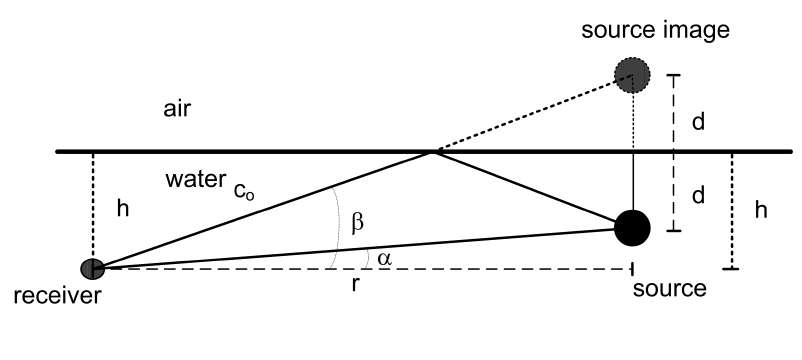
Figure 1. Geometry of the source image